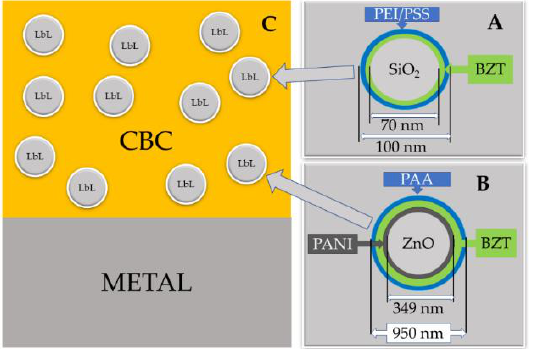
Figure 23. ( A – C ) Schematic representation of the SiO 2 and ZnO LbL technology.